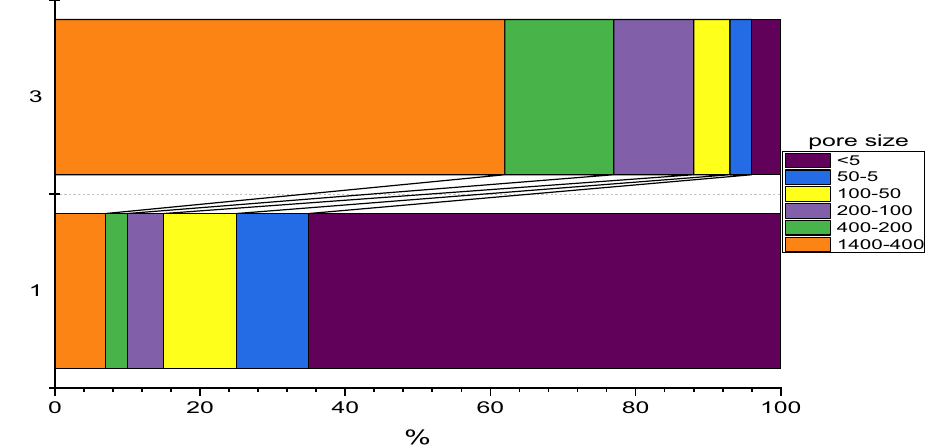
Figure 1. Percentage distribution of uranium in the filtrate during sequential filtration of samples 1 and 3. Concentrations of U in the filtrates were determined by the ICP-MS